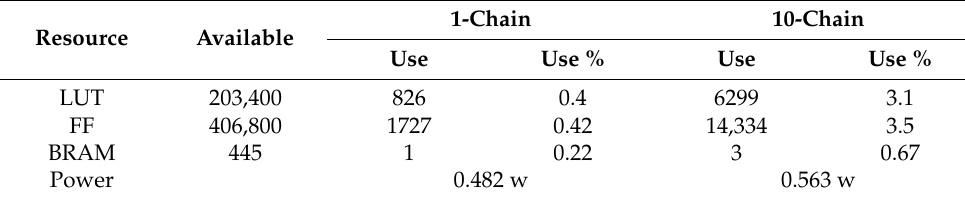
Table 1. Resources usage and power consumption of the